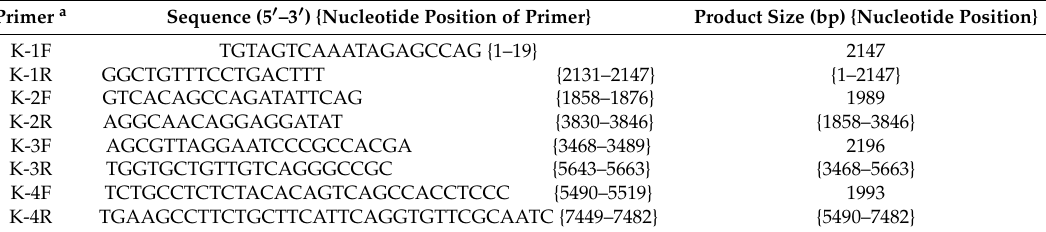
Table 1. Primers used for amplifying the full-length proviral genome in this study. Primer a Sequence (5 (cid:48) –3 (cid:48) ) {Nucleotide Position of Primer} Product Size (bp) {Nucleotide Position}